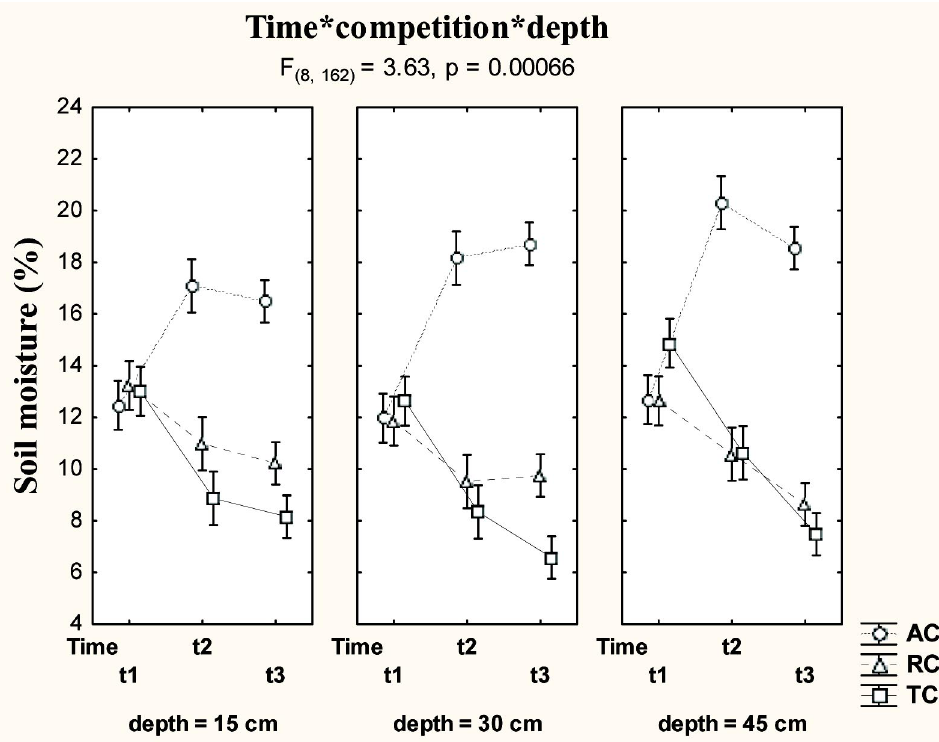
Fig. 1. Variation of soil moisture with herb competition, soil depth, and time before the application of the irrigation treatment. AC = absence of competition; RC = reduced competition, TC = total competition. Time notation is as follows : t1 = 15 March, t2 = 5 May, and t3 = 22 May. Every point in the graph is the average of 20 measurements. Bars are standard